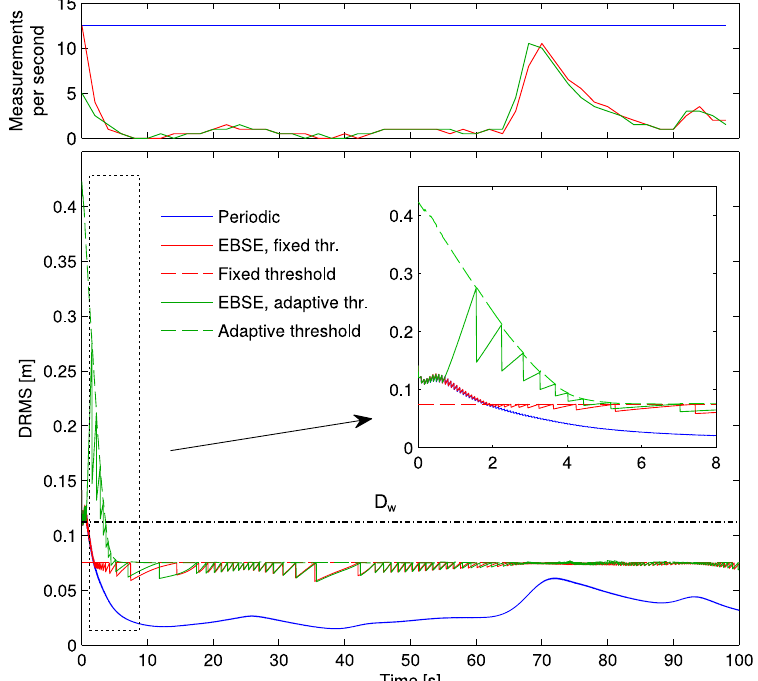
Figure 7. Measurement rate and evolution of the distance root mean squared error (DRMS) over time for the three estimation methods. The threshold values are also shown. The approaching time (until the eighth second of the simulation) is zoomed in the plot in the top left